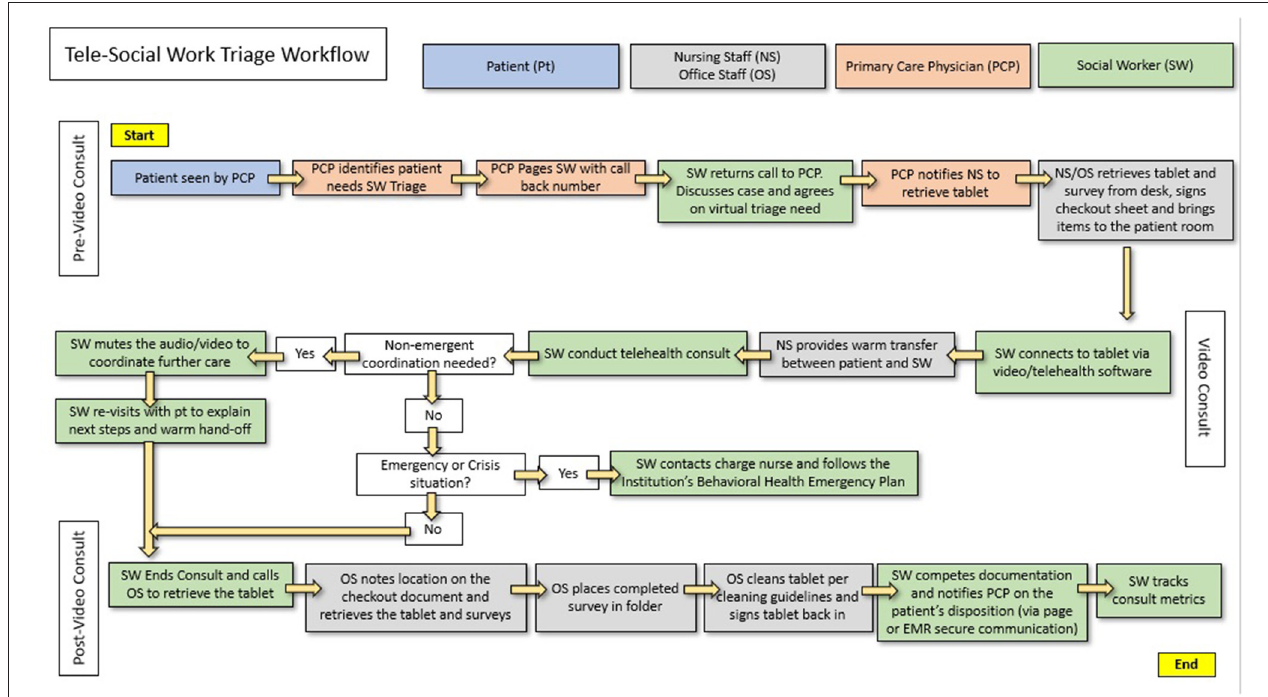
FIGURE 1 | Tele-social work triage workflow starting with the patient being seen by the primary care physician, followed by the tele-social work encounter, ending in consolidation and tracking of the consultation metrics.